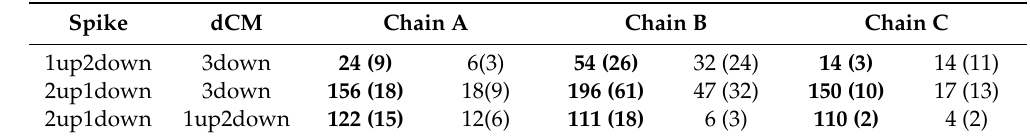
Figure 3. The same analysis as in Figure 2 but for the spike protein with 2up1down RBD conformation. Panel ( A ) shows the structure of the S protein and in green the amino acid residues that destabilize the spike protein in the 2up1down conformation. The bottom of panel ( A ) shows the same structure rotated by 90° as indicated, showing that most of the destabilizing residues are positioned along S1, RBDs and NTDs in chains B and C. Panel ( B ) shows the stabilizing residues in black. Panel ( C ) shows the plot of the contact map. The squares follow the color convention for each protomer and each dot represents a high-frequency contact (i.e., green = destabilizing and black = stabilizing). Table 1. Differential contact map analysis of the spike protein calculated for every single protomer A, B, and C. We show the total number of destabilizing (denoted in bold) and stabilizing residues and their corresponding number of intrachain contacts with freq > 0.9 in parentheses.